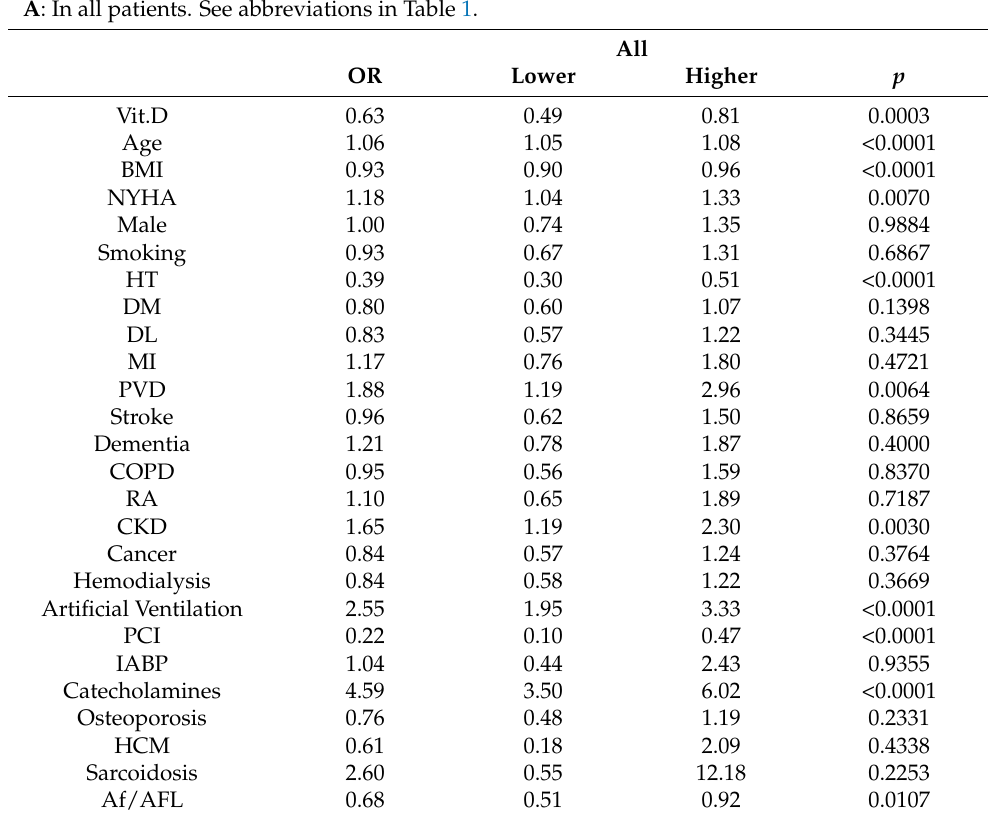
Table 3. Multivariate analysis of covariates for in-hospital mortality. A : In all patients. See abbreviations in Table